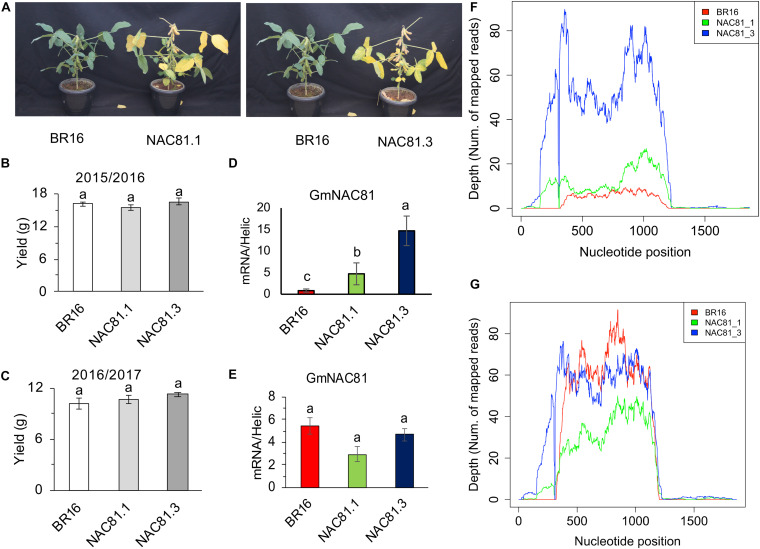
GmNAC81 overexpression accelerates leaf senescence. (A) Phenotype of GmNAC81-overexpressing lines and the cultivar BR16 at 90 days after germination (DAG). (B) Mass of grains of BR16 and GmNAC81 lines in the first growing season (2015/2016) (mean ± standard error). Means followed by different letters are significantly different by t-test (p < 0.05). (C) Mass of grains of BR16 and GmNAC81 lines in the second growing season (2016/2017) (mean ± standard error). Means followed by different letters are significantly different by t-test (p < 0.05). (D) Normalized expression of GmNAC81 at 20 DAG. The accumulation of transcripts of GmNAC81 was determined by 2–ΔΔCt (mean ± standard error). Means followed by different letters are significantly different by t-test (p < 0.05). (E) Normalized expression of GmNAC81 at 80 DAG. The accumulation of the GmNAC81 transcripts was determined by 2–ΔΔCt (mean ± standard error). Means followed by different letters are significantly different by t-test (p < 0.05). (F) High throughput sequencing reads mapped to the GmNAC81 locus (Glyma.12G022700, Phytozome 12) at 20 DAG. (G) High throughput sequencing reads mapped to the GmNAC81 locus at 80 DAG.